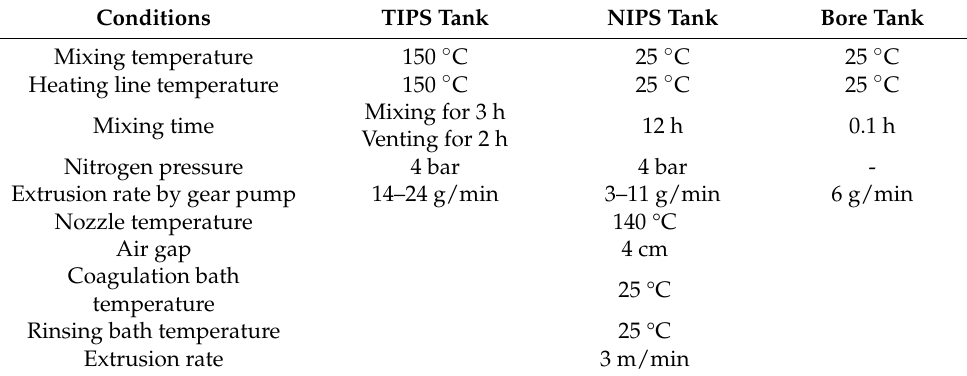
Figure 3. Schematic diagram of TIPS and NIPS simultaneous spinning machine. Table 2. Various spinning conditions of single and dual-layer hollow fiber Table 2. Various spinning conditions of single and dual-layer hollow fiber membranes.